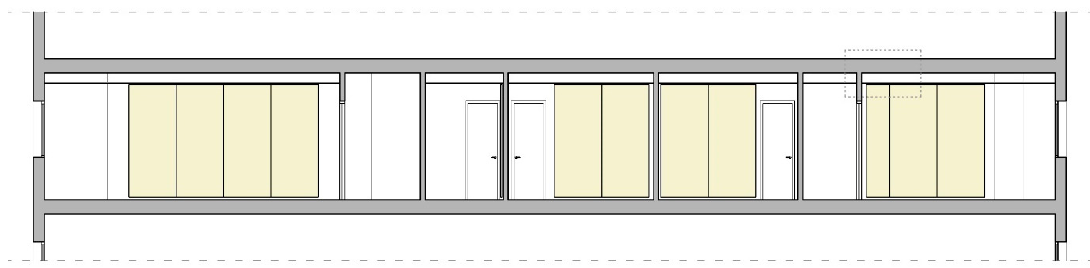
Figure 9. The cross-section of the home under study. Thermal ceramic panels (TCP) in yellow.